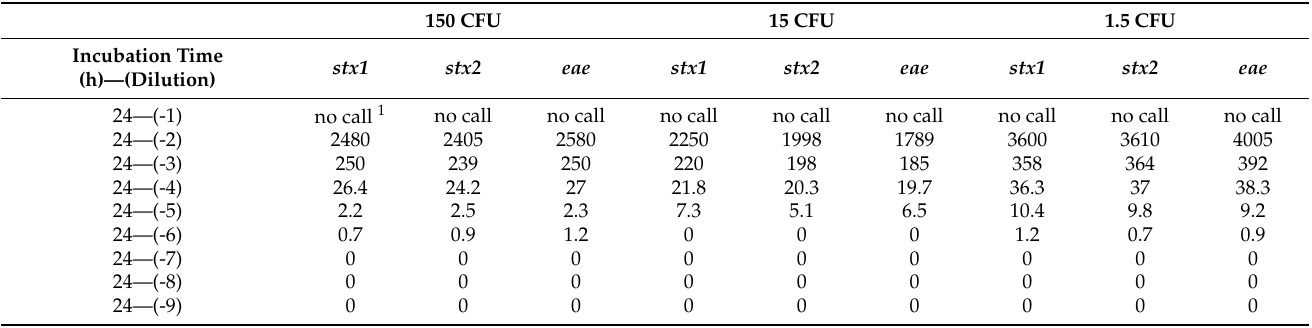
Table 4. Number of copies/ µ L detected by droplet digital PCR in different dilutions prepared from sponges artificially contaminated with different concentrations of E. coli O157:H7 (150, 15, and 1.5 CFU/mL) and incubated at 37 ◦ C for 24 h. 15 CFU